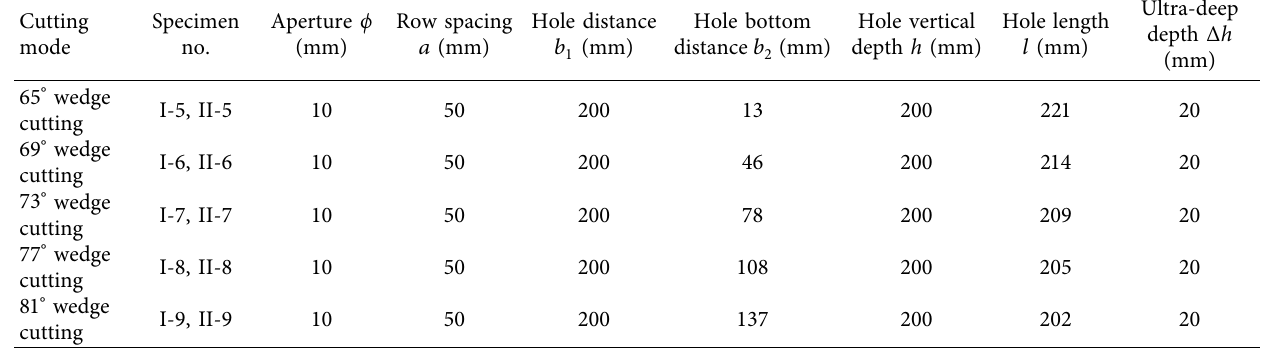
Table 3: Blasting model experiment program.